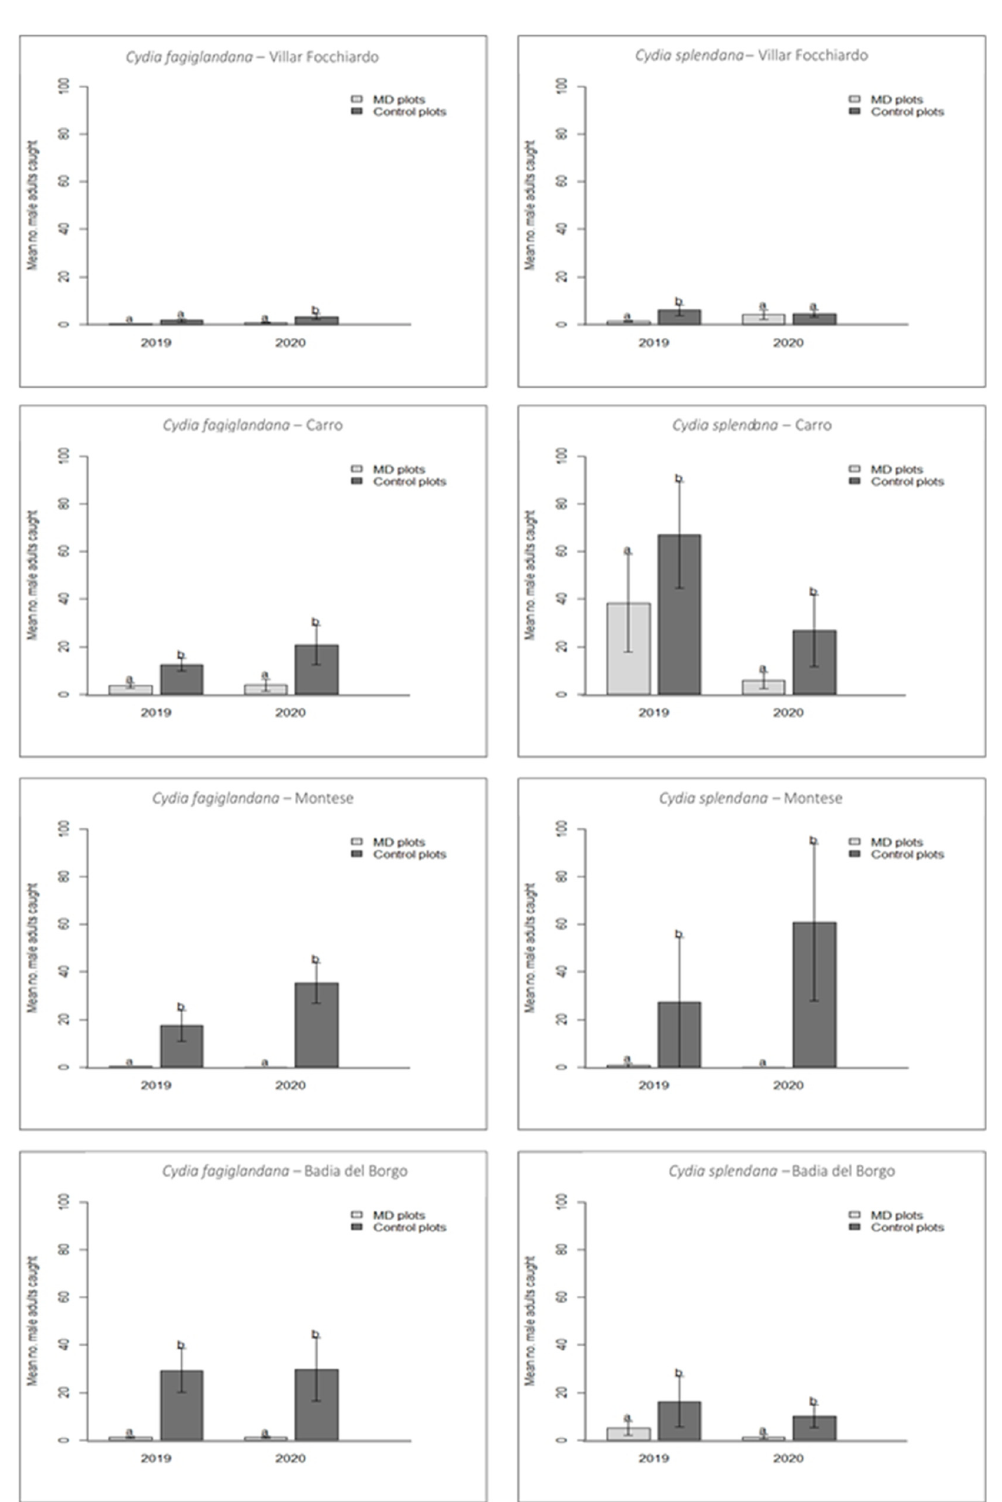
Figure 2. Average number (±SEM) of male adults of Cydia fagiglandana ( left ) and Cydia splendana ( right ) collected with pheromone-baited traps, in plots where mating disruption (grey histograms) was applied compared to control plots (black histograms) in 2019 and 2020. Bars with different letters are significantly different, according to the paired t-test ( p < 0.05). Male trap catch suppression in MD plots averaged 89.5% and 93.8% for C. fagiglandana , and 57.4% and 81% for C. splendana in 2019 and 2020, respectively.